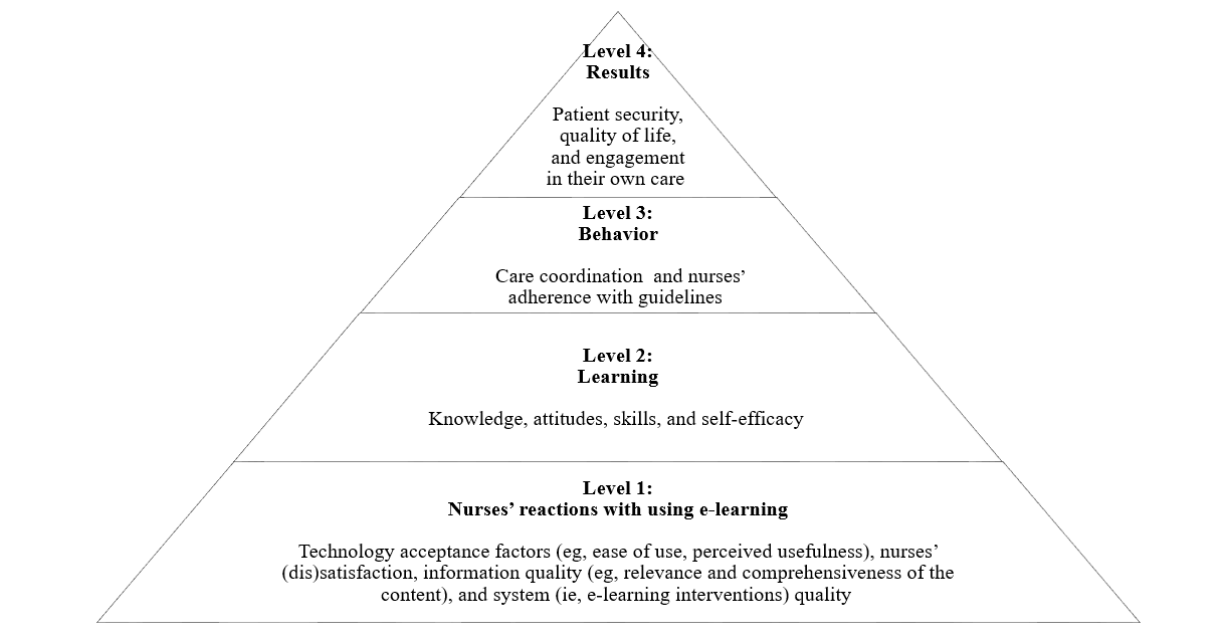
Figure 1. The Kirkpatrick